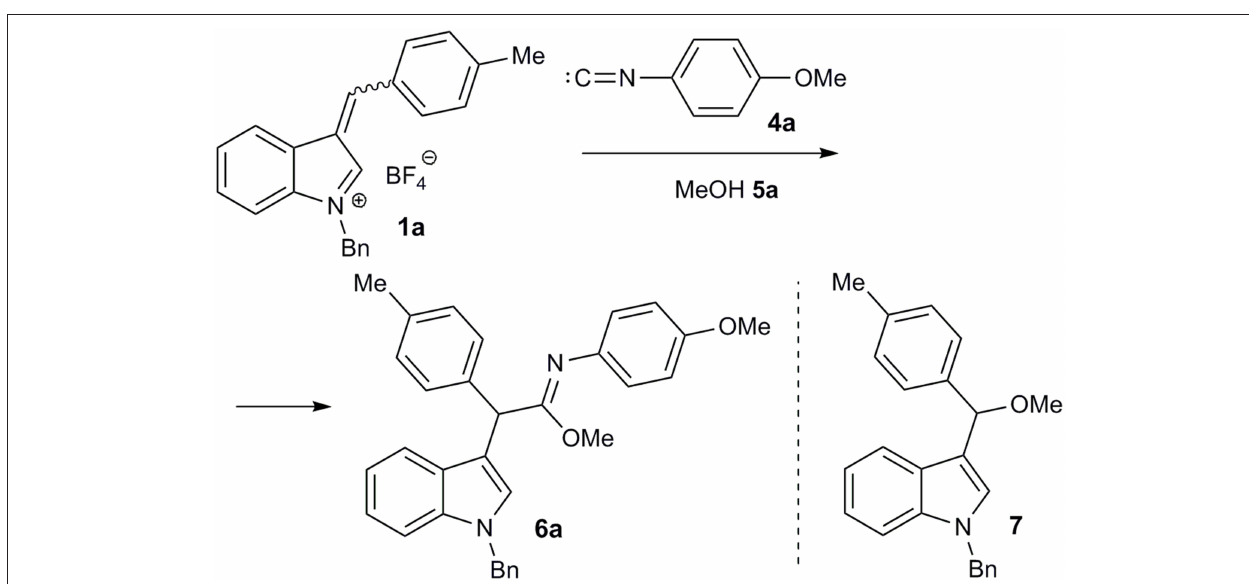
FIGURE 3 | Reaction optimisation for imidate 6a